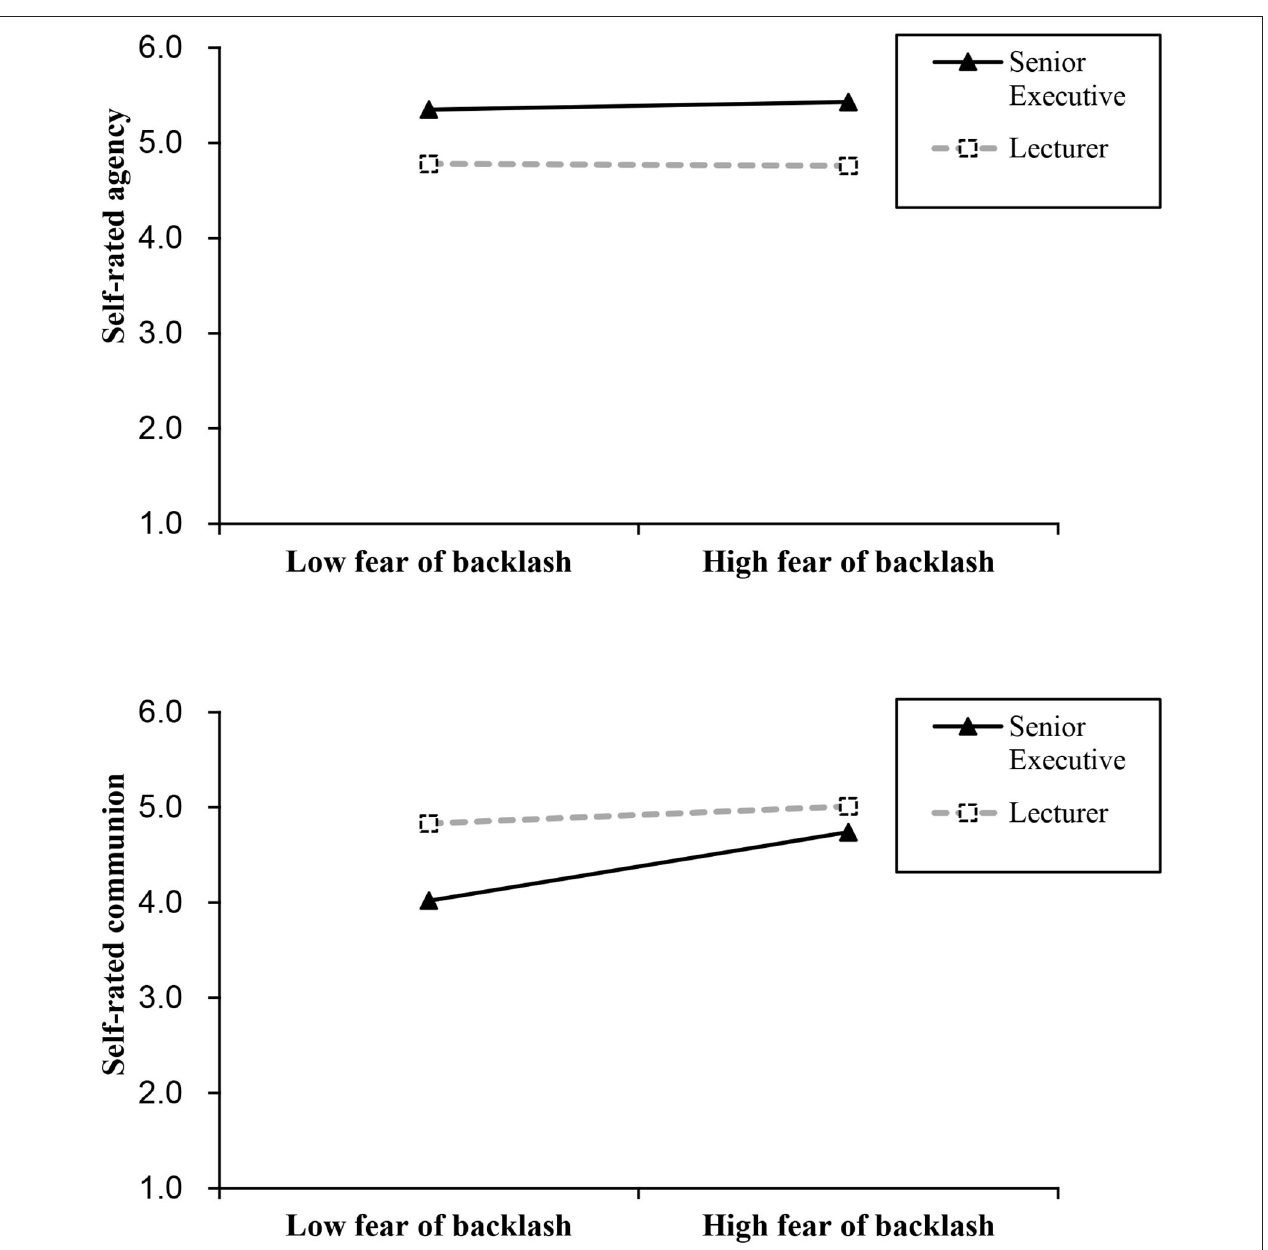
FIGURE 6 | Simple slope analysis for moderation effect of fear of backlash on the relationship between the role type of women and self-reported agency and communion in Study 3. N = 202 women ( N Executive = 96, N Lecturer = 106).